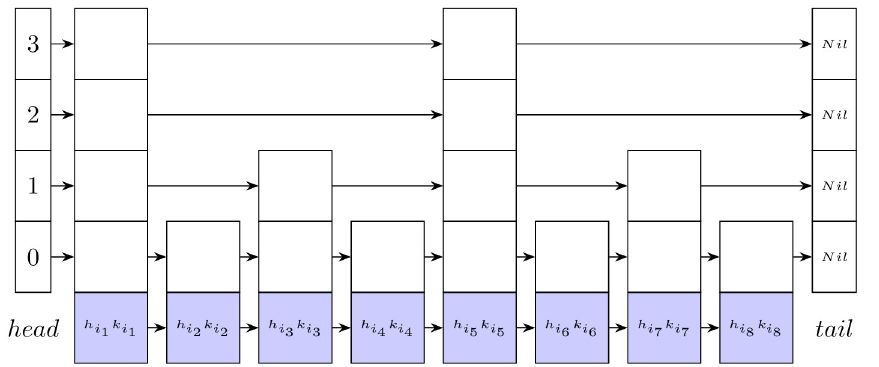
Fig 5. A skip list consisting of 4 linked lists. The original list of pairs (vertices, keys) is at level 0 and sorted in ascending order. Each level contains a sublist from the preceding